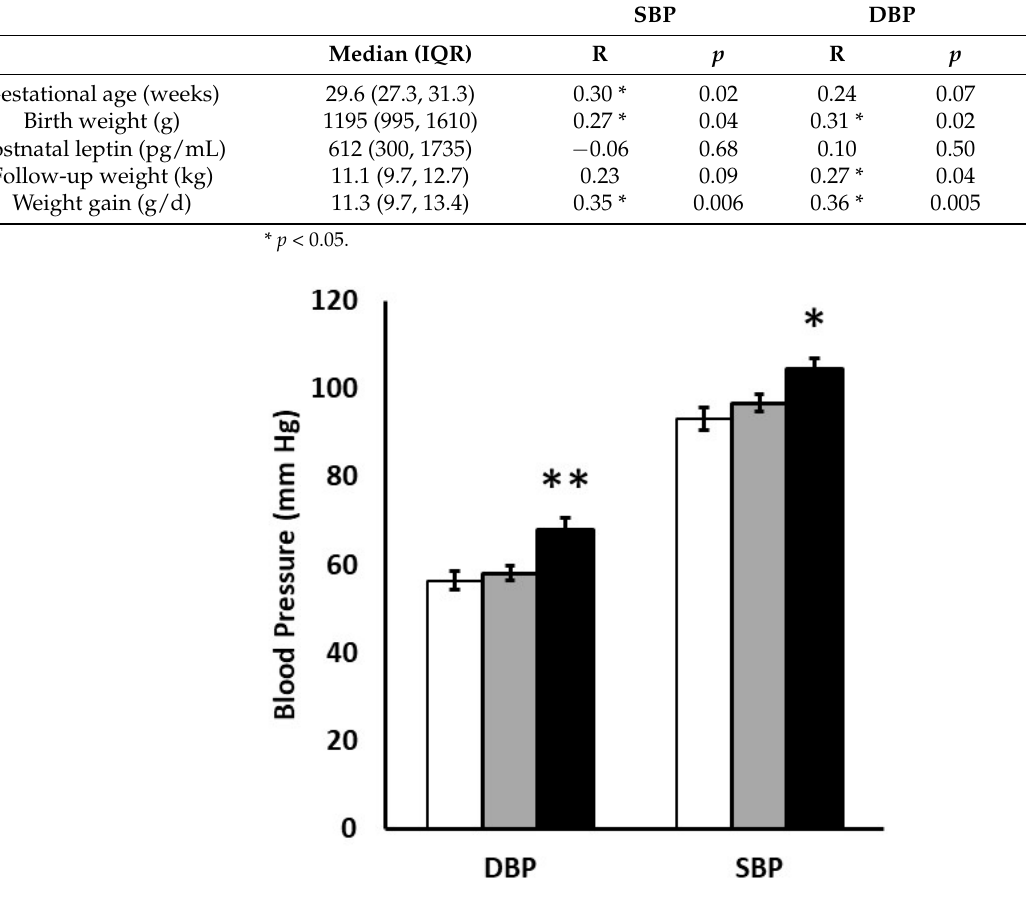
Figure 2. Diastolic blood pressure (DBP) and systolic blood pressure (SBP) are contrasted for children with slow weight gain velocity (<10 g/d, open bars, N = 18), typical weight gain velocity (10–15 g/d, gray bars, N = 30) or rapid weight gain velocity (>15 g/d, black bars, N = 10). * p < 0.05 or ** p < 0.01 versus 10–15 g/d cohort.